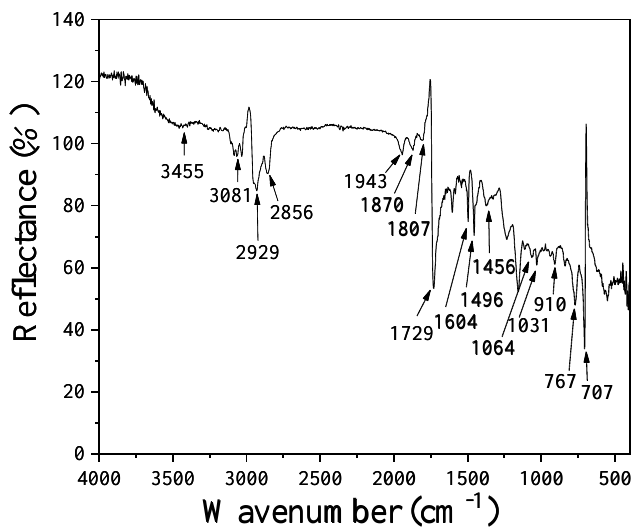
Figure 3. Fourier Transform Infrared (FT-IR) spectrum of the as-synthesised core/shell Poly(St-MMA- AA) nanoparticles (308.3